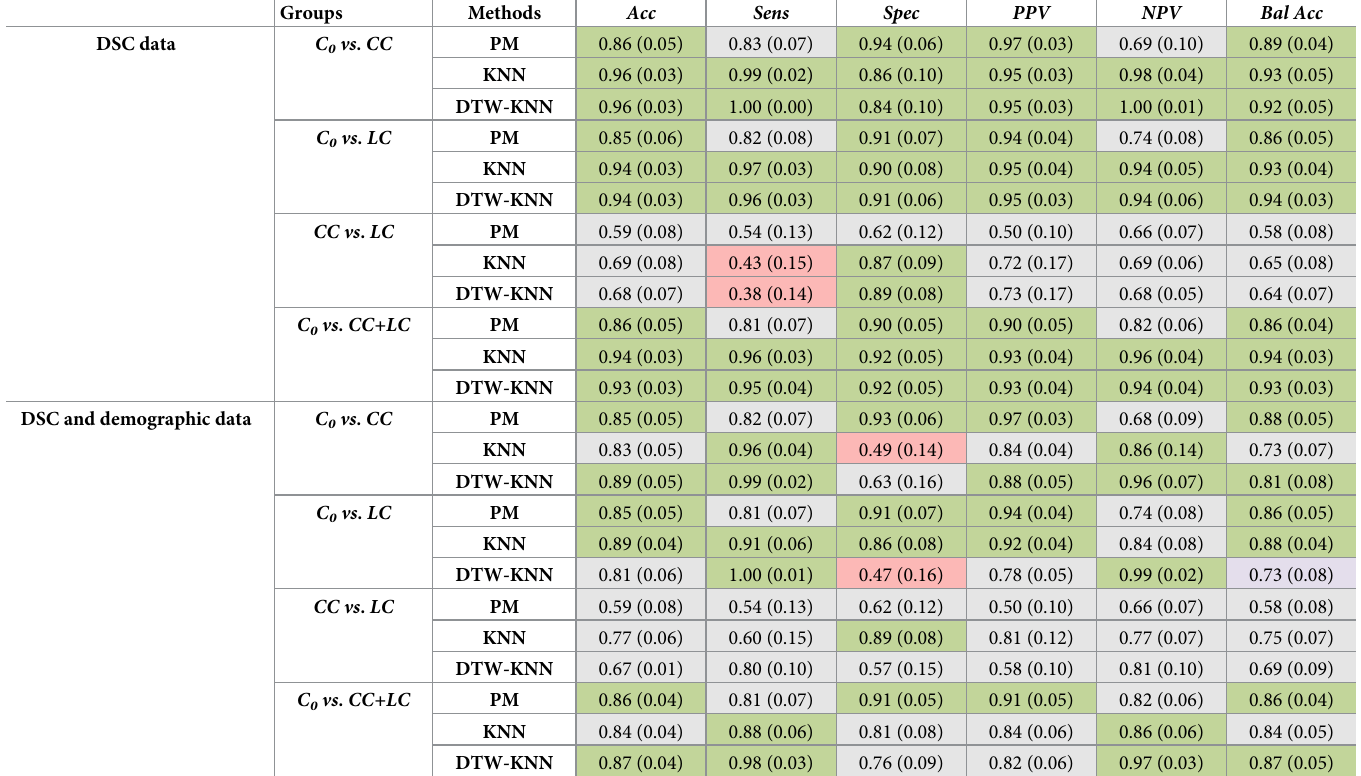
Table 4. Results of two group classification methods.